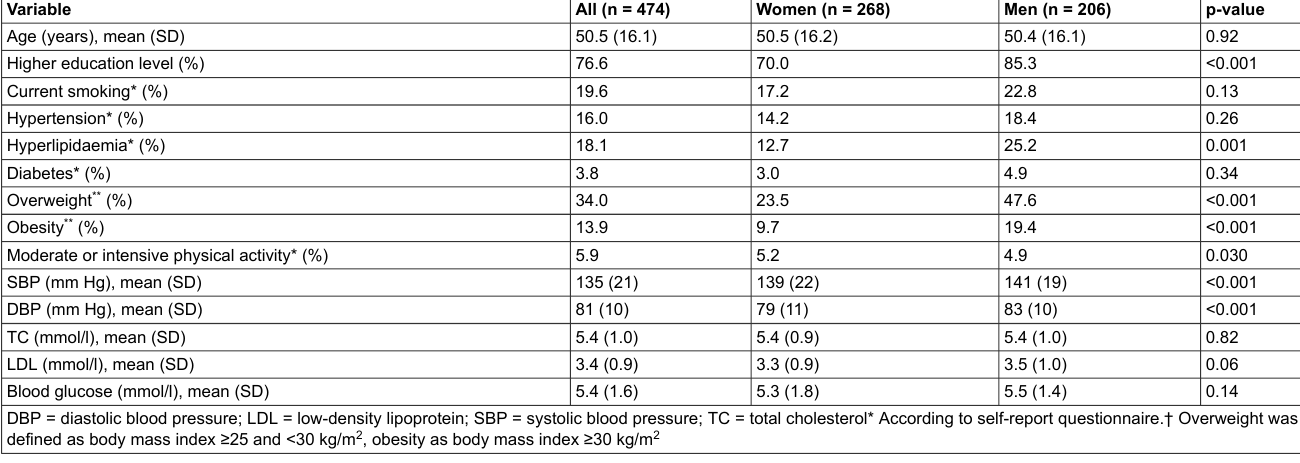
Table 1: Baseline characteristics of the participants.